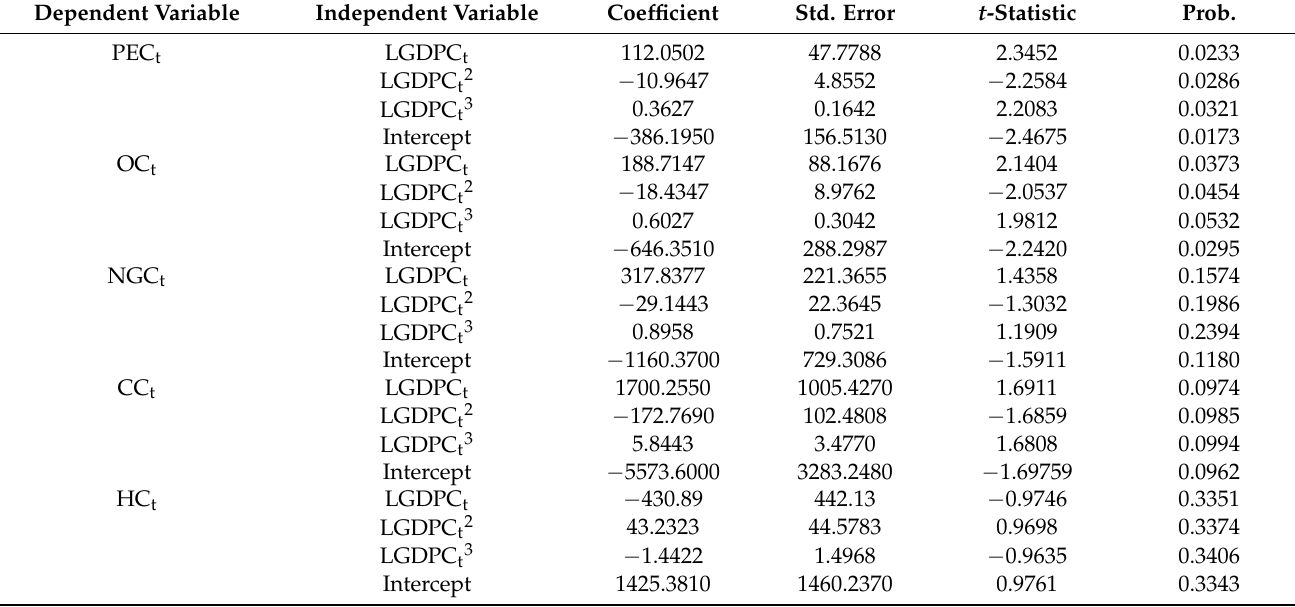
Table 4. Long run